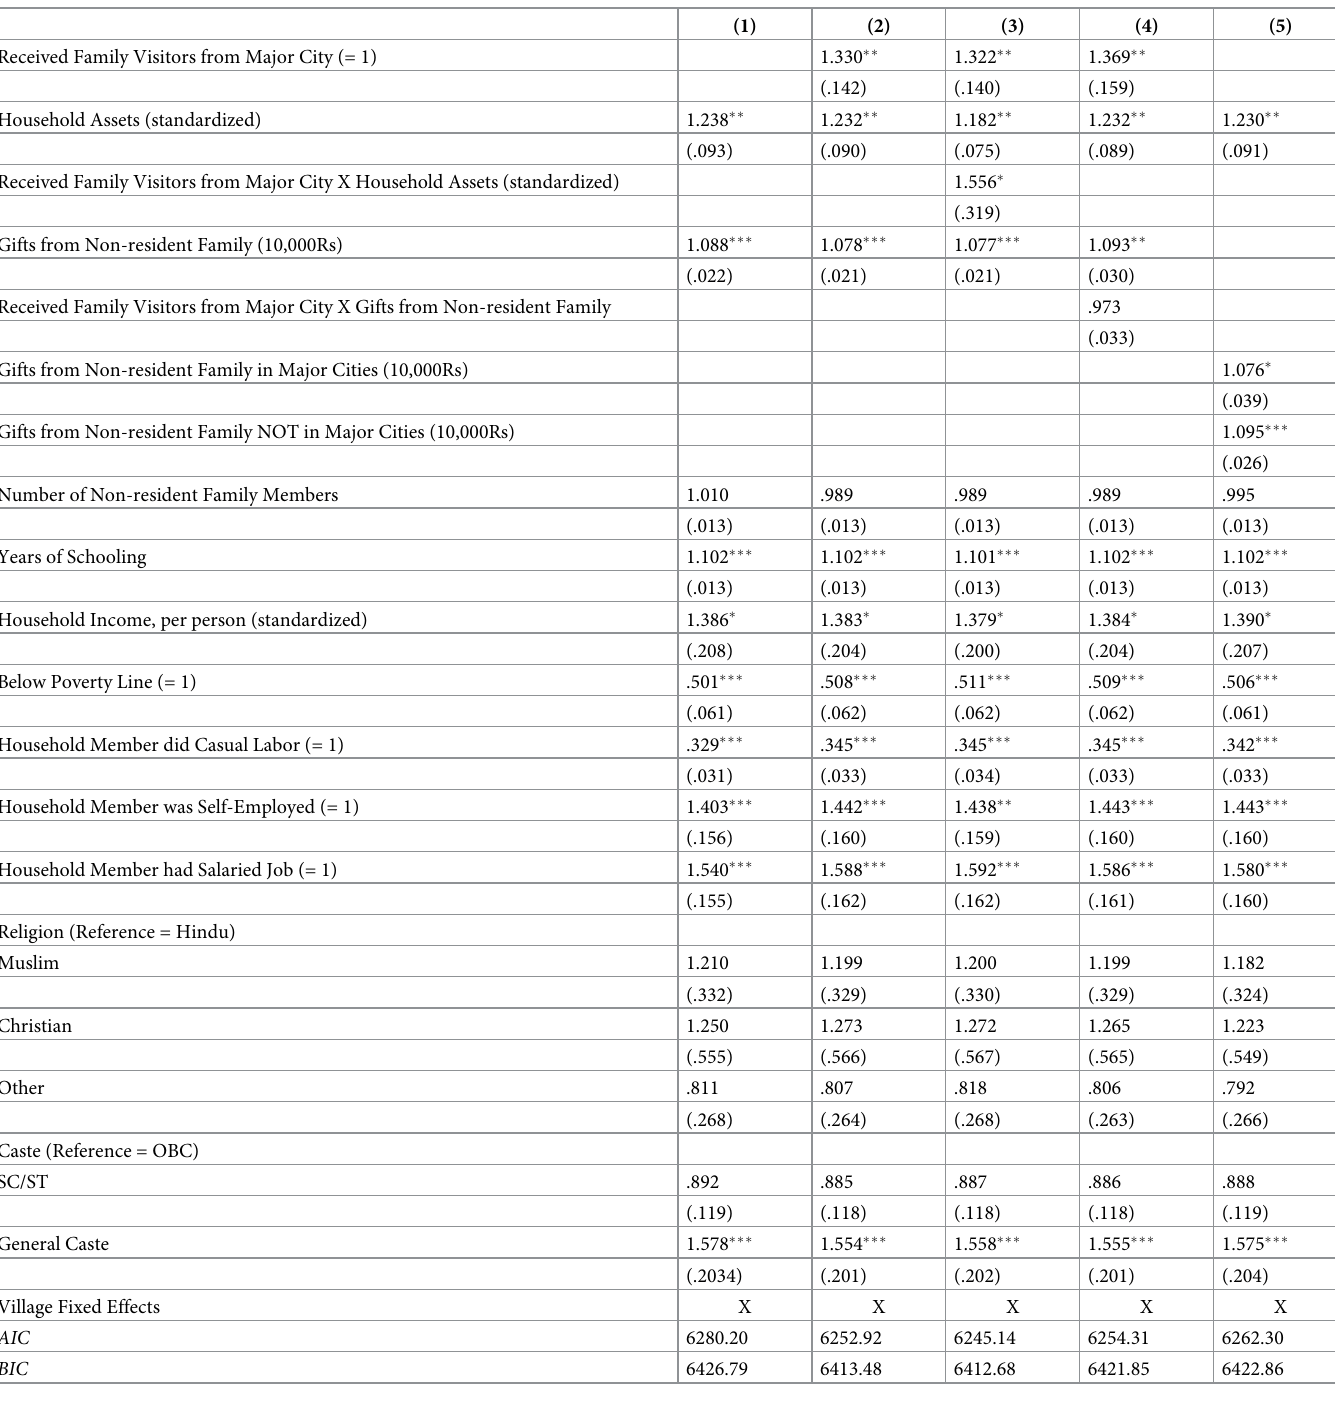
Table 2. Logistic regression predicting odds of household